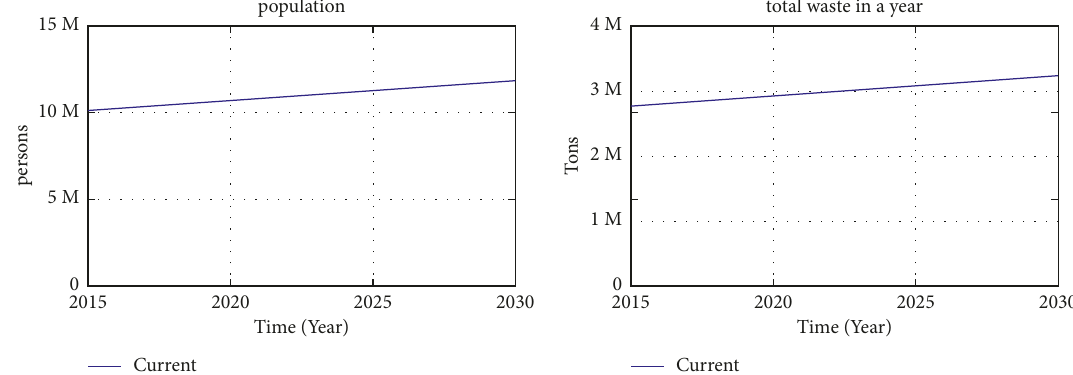
Figure 4: Simulation results of the total population of Jakarta and the amount of waste until 2030.